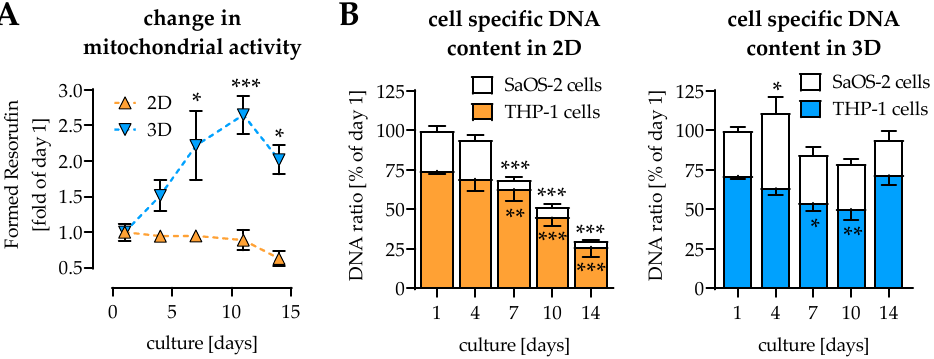
Figure 1. Comparison of viability of THP-1 cells and SaOS-2 cells in 2D and 3D coculture. THP-1 cells and SaOS-2 cells (2:1 ratio) were cocultured over 14 days in 2D and 3D on pHEMA-based cryogel scaffolds. On days 1, 4, 7, 10, and 14 of culture, ( A ) mitochondrial activity (Resazurin conversion) and ( B ) cell-specific DNA content were measured. Data are presented as curves or bar charts (mean ± SEM). Changes over time were compared by nonparametric Friedmann test, followed by Dunn’s multiple comparison test. Cell-specific DNA contents were compared by nonparametric two-way ANOVA, followed by Tukey’s multiple comparison test. * p < 0.05, ** p < 0.01, and *** p < 0.0001 as compared to the respective day 1. N ≥ 3 and n = 3.